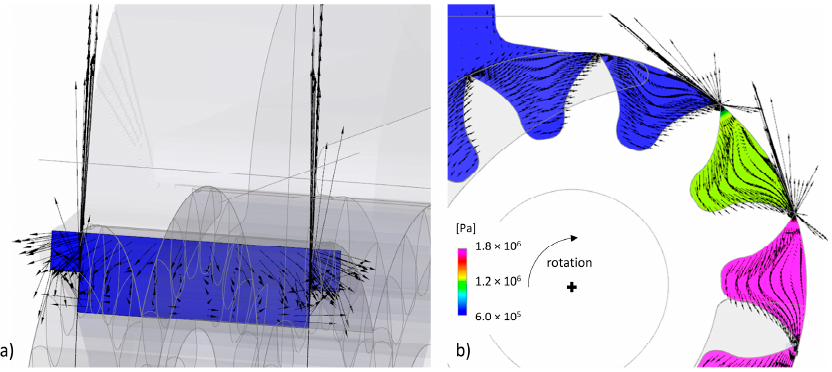
Figure 8. Mass flow rate trend according to the angular position of the wheel (see reference position).